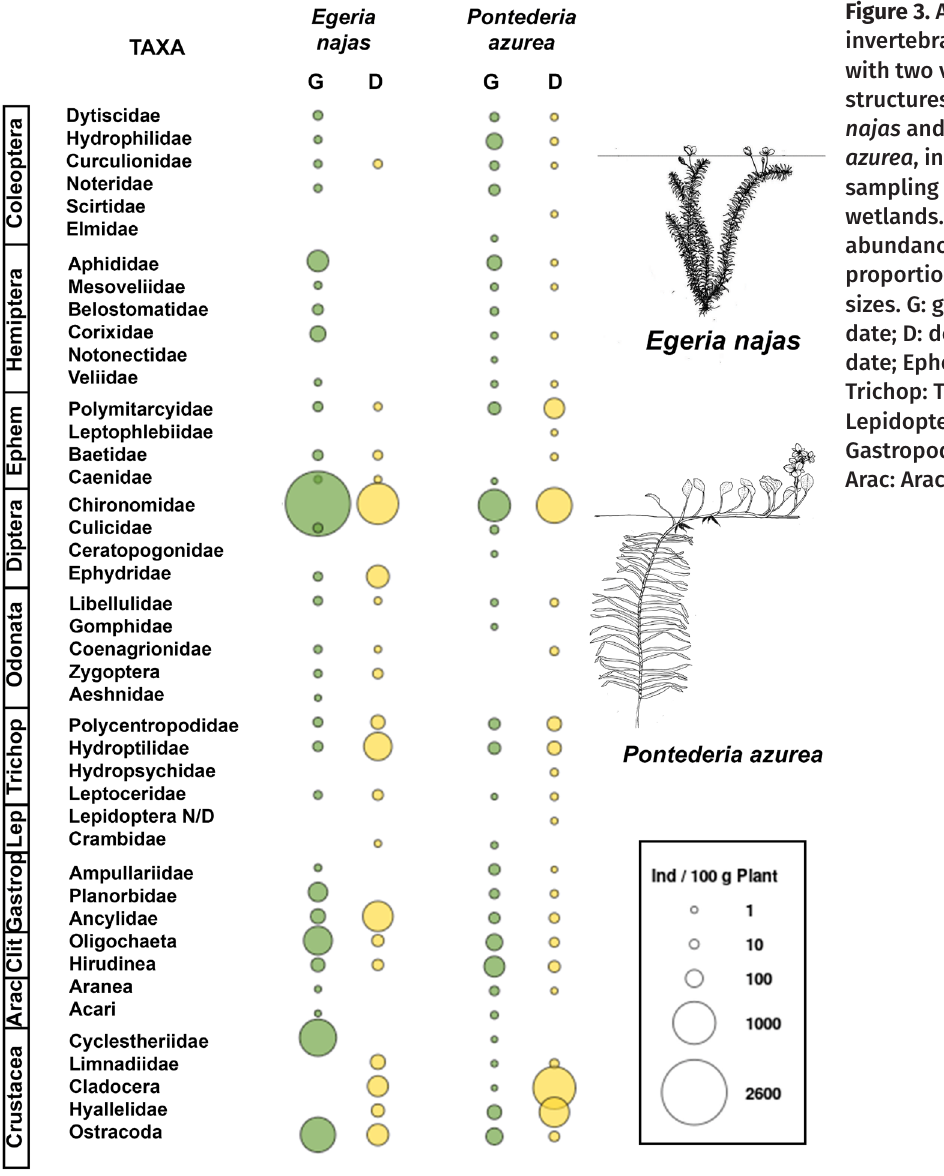
Figure 3. Abundance of invertebrate taxa associated with two vegetation structures, the S Egeria najas and the FR Pontederia azurea , in growth and decline sampling dates, at the Iberá wetlands. Invertebrates’ abundance is indicated proportionally with